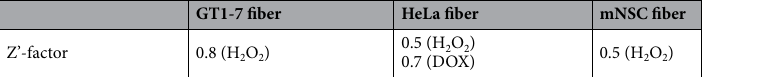
Table 2. Z’-factors of arrays of the CF fragments on a 96-well plate. The z’-factors obtained from bioluminescence assays for cell viability assessments using the arrays of the CF fragments of GT1-7 cells, HeLa cells, and mNSCs were calculated. The z’-factors were calculated by substituting the values for the positive and negative control in the Eq. (2). The acceptance criterion was set as follows: z’-factor ≥